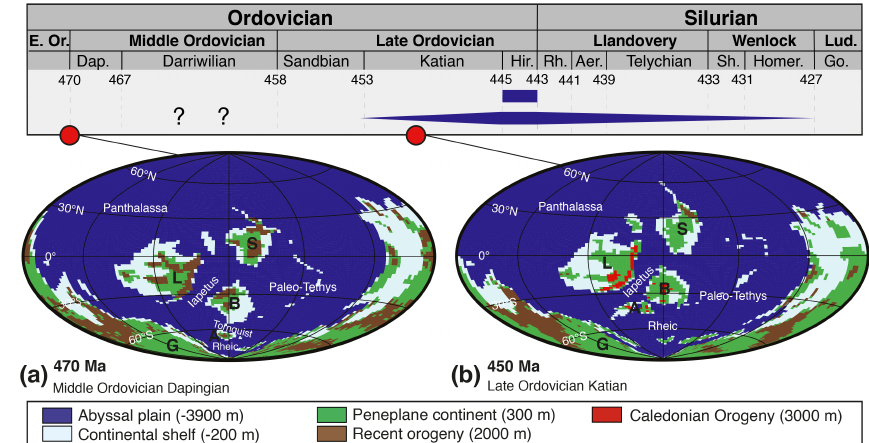
Figure 1. Continental configurations with the FOAM ocean grid based on the paleogeographical reconstructions from Blakey (2007), with the color code for the bathymetric and topographic categories used in this study. G: Gondwana, A: Avalonia, B: Baltica, L: Laurentia, S: Siberia. Ocean names are shown. Each time slice is replaced on the synthetic Ordovician glaciation chronology (inspired from Finnegan et al., 2011). Age limits are taken from the geological time scale v2014/02 (International Commission on Stratigraphy, 2014). Question marks are time intervals when hypothetical first ice sheets may have appeared according to Turner et al. (2012). Blue bars represent the two scenarios considered today for the duration of the Ordovician glaciation (see Sect. 2.2. for a full